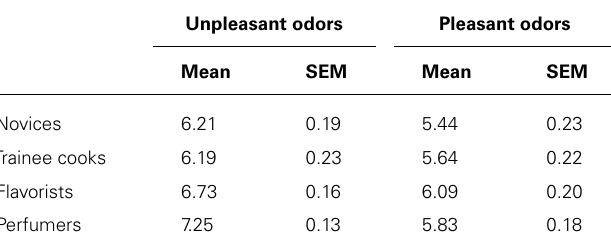
Table 2 | Intensity ratings of pleasant and unpleasant odors in novice (untrained) subjects, trainee cooks, flavorists, and perfumers. Unpleasant odors Pleasant